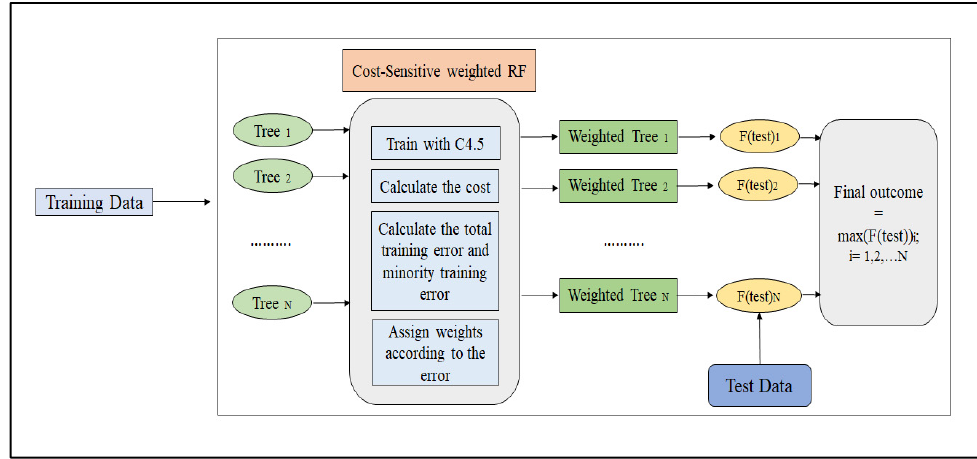
Figure 7. The suggested cost-sensitive weighted Random forest technique’s framework.